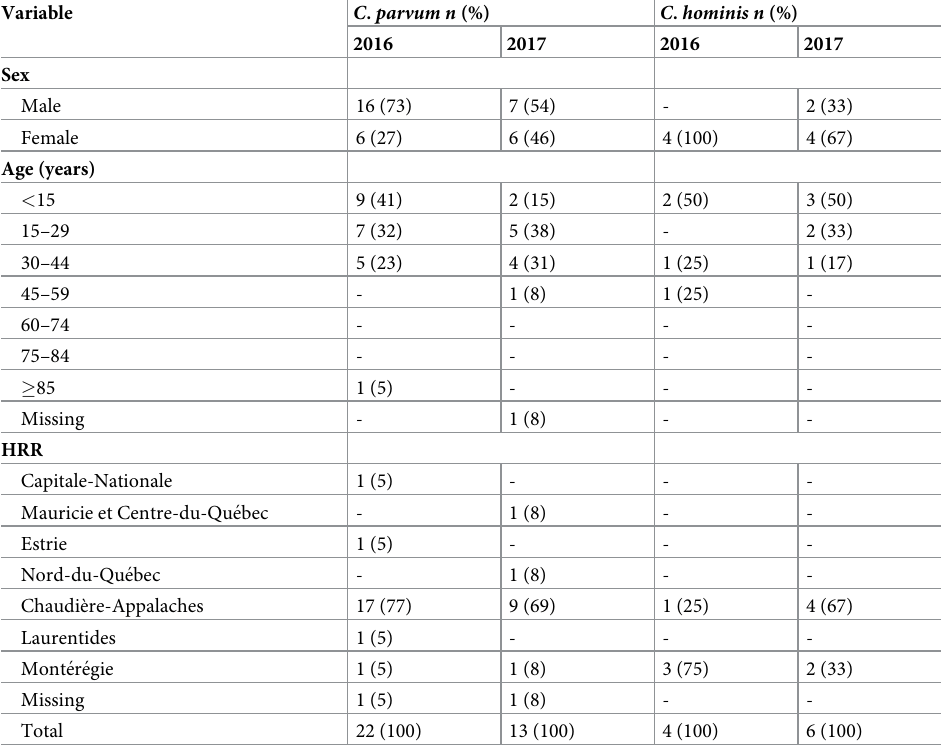
Table 2. Number and percentage of confirmed reported cases by Cryptosporidium species in Que´bec, Canada, 2016–2017. Variable